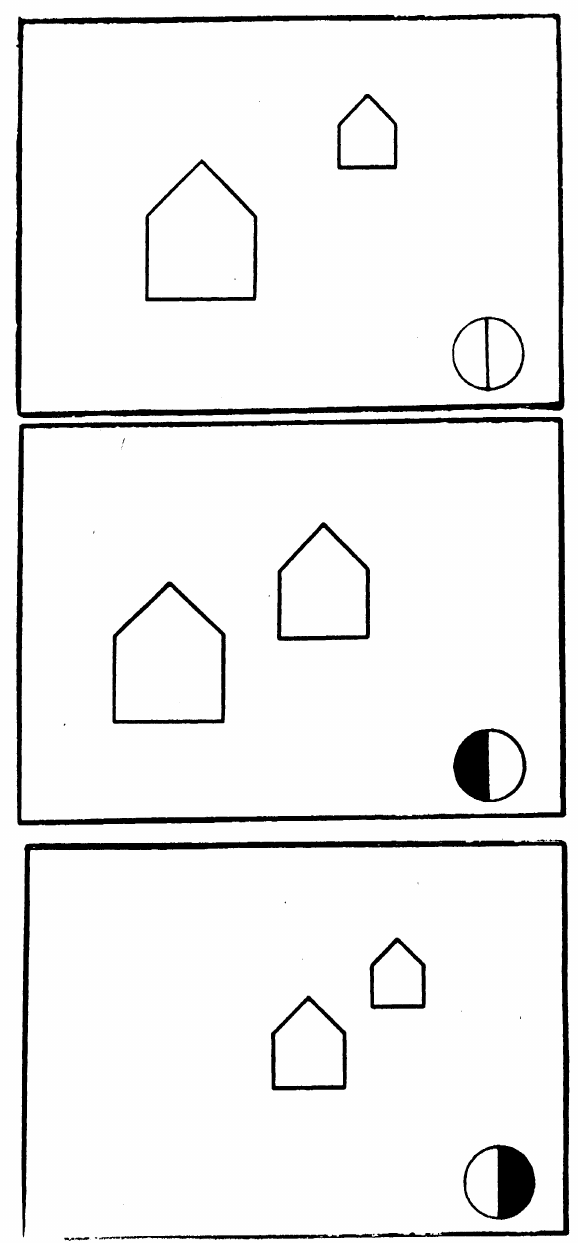
FIG. 3. Drawings of two houses, one at close quarters and the other in the distance. The drawings are repro duced using measurements of the drawing area as well as the position of the drawings on the paper. These draw ings represent averages for 22 control patients, 27 patients with left hemisphere suppression and 31 patients with right hemisphere suppression. The sup pressed hemisphere is